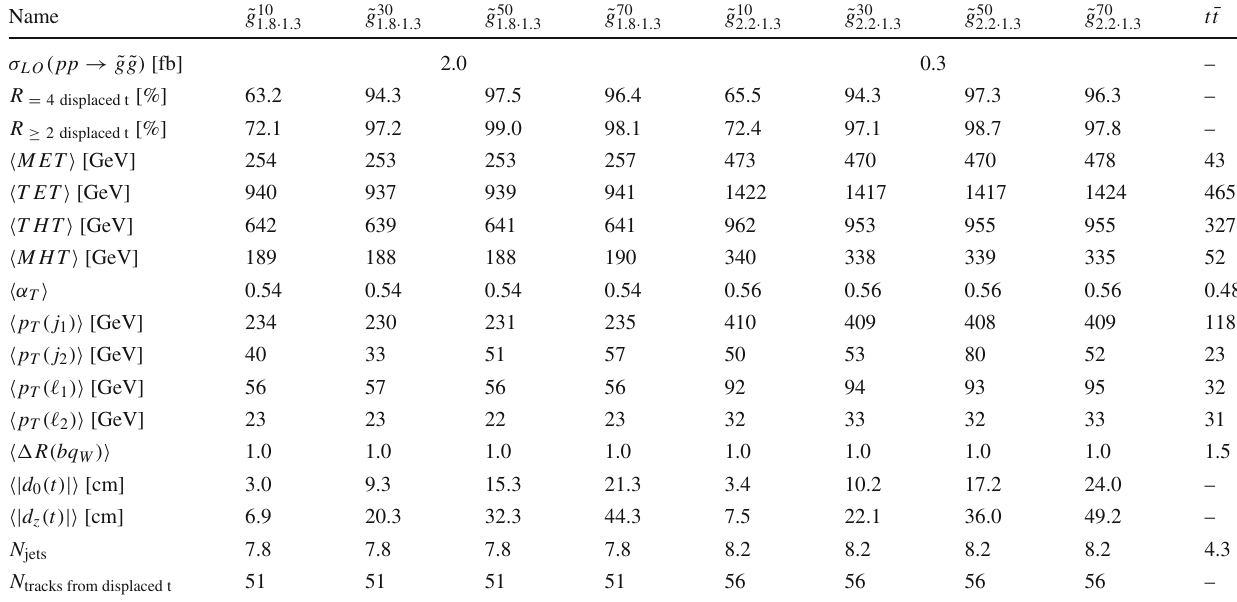
Table 8 Mean values of some observables and number of events with top quarks decaying in the tracker volume for the eight benchmarks of the long-lived gluino analysis. We remind that R ≥ 2 displaced t corre-